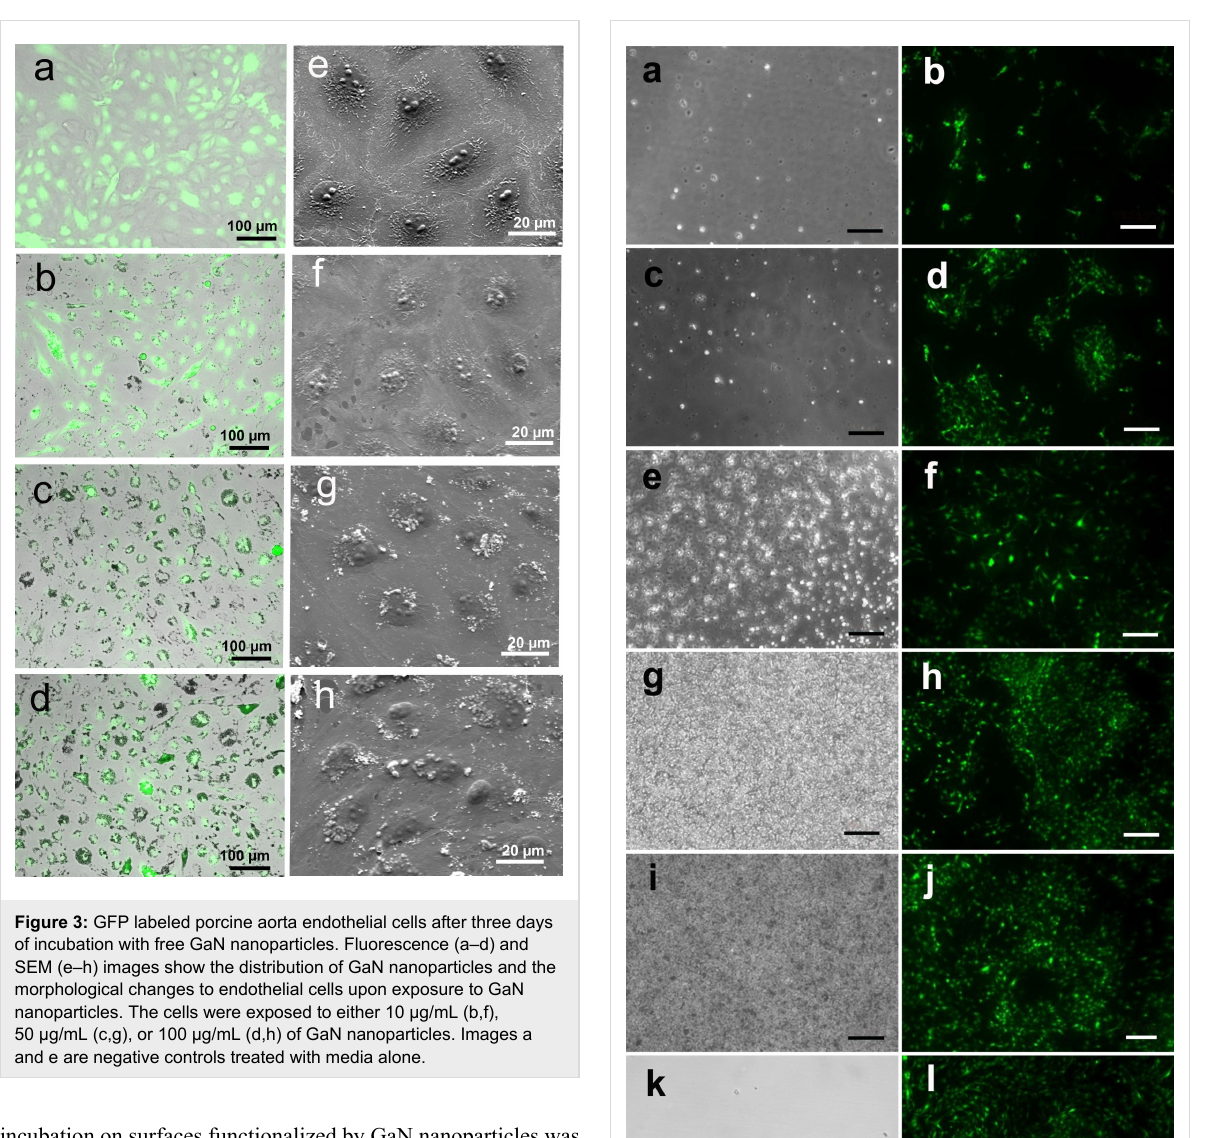
tively short period of time, while similarly sized GaN nanoparti- cles, applied at the same concentration, were taken up by endo- thelial cells, which continued their proliferation process. It is widely believed that the toxicity of ZnO nanoparticles is a result of chemical instability and involves an increase of Zn 2+ in the culture medium